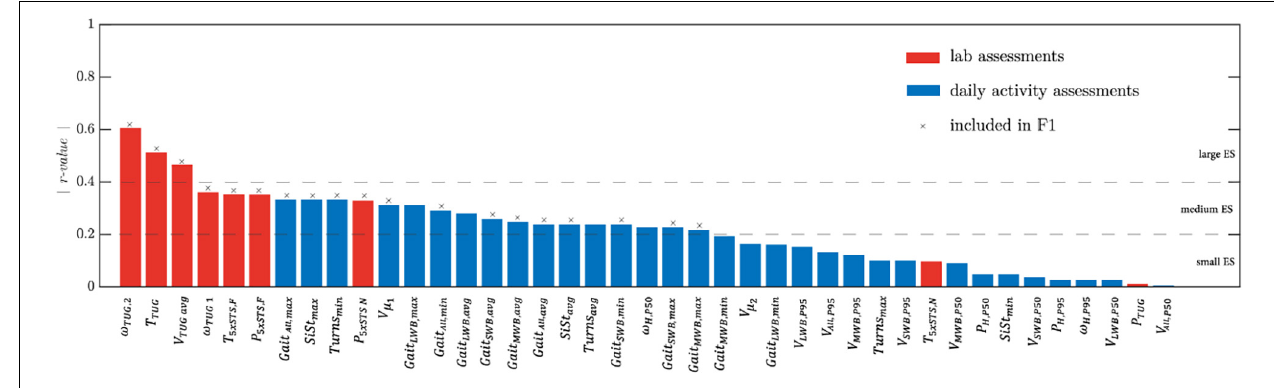
TABLE 4 | The performance metrics of the classification of PD-FOF+ vs. PD-FOF − . Feature set Sensitivity (%) Specificity (%) Precision (%) Accuracy (%) AUC